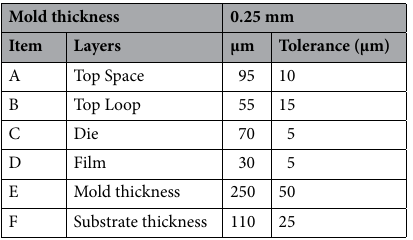
Table 1. The quality characteristics and specifications for driver IC.